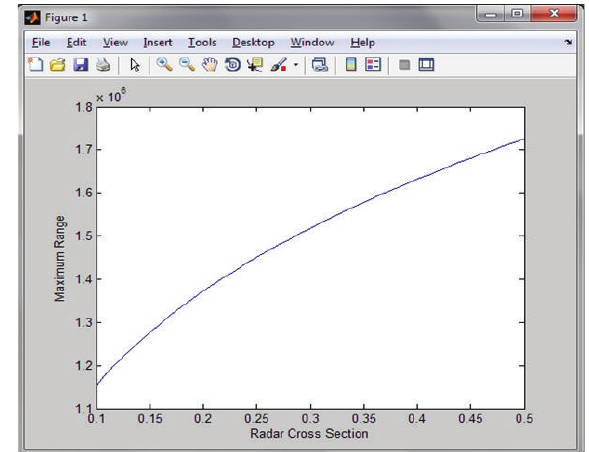
Figure 12: Variation in RCS of two isotropic scatterers with frequency.